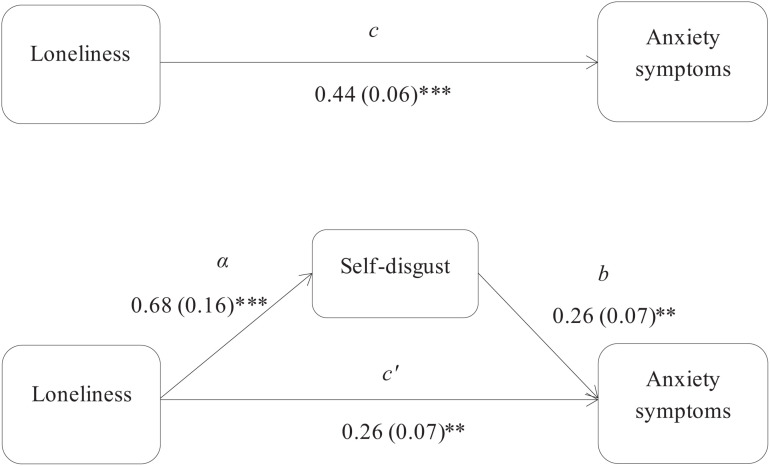
Self-disgust mediates the association between loneliness and anxiety symptoms in the non-PTSD group. Note: The total (c) and the indirect effect (c’) of loneliness on anxiety symptoms are shown. Unstandardized path coefficients are presented, with standard errors in brackets. ∗p ≤ 0.05; ∗∗p ≤ 0.005; ∗∗∗p ≤ 0.001.